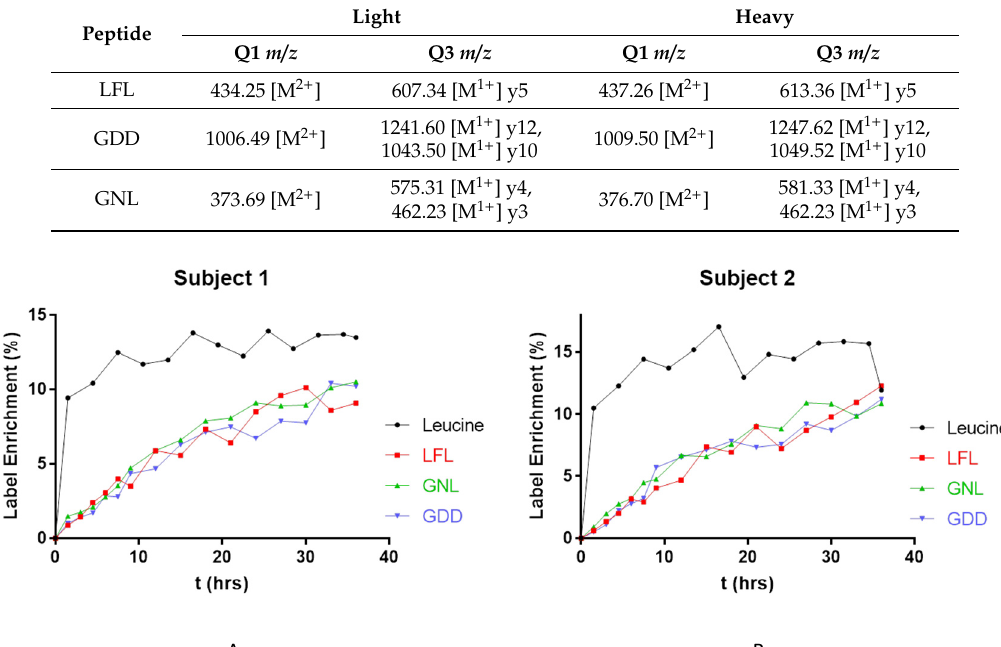
Figure 4. Levels of labeled leucine enrichment in plasma of Subject 1 ( A ) and Subject 2 ( B ) were shown by the black line. Tracer leucine incorporation into FcRn was monitored by three FcRn peptides, LFL (red line), GNL (green line), and GDD (blue line).